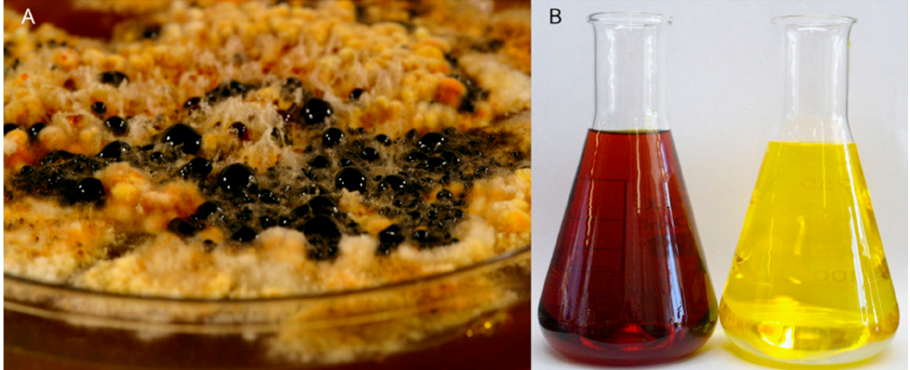
Figure 2. Bioactive exudate produced by Epicoccum nigrum ICMP 19927 when growing on complex medium at 25 ° C for 14 days ( A ). Crude methanol extract of E. nigrum culture in two different dilution ( B ). Diluted crude methanol extract reveals the presence of bright yellow compounds.